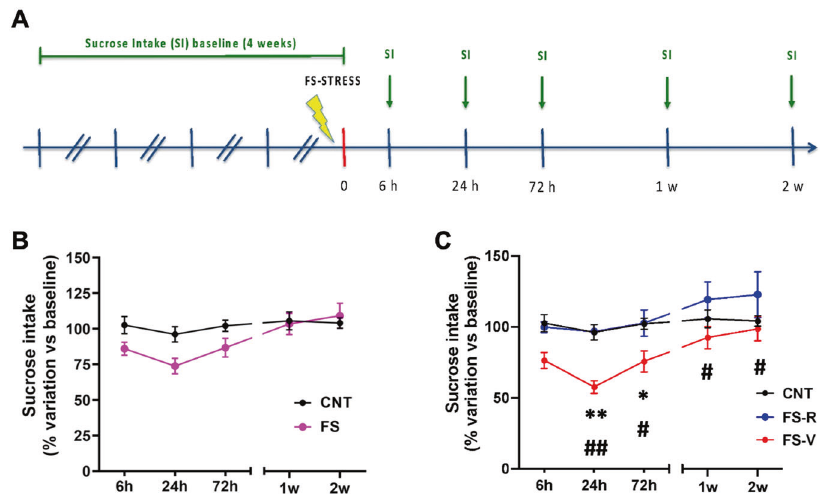
Fig. 2 Time course of sucrose intake in FS-R and FS-V animals. A Experimental plan timeline. Basal sucrose intake was established as before, animals were subjected to a single session of FS, and sucrose intake test was performed 6 h, 24 h, 72 h, 1 week, and 2 weeks after stress exposure. B Time-course of sucrose intake in CNT and FS rats. Mixed-effects model, Š ídák post-hoc test; N = 8 (CNT), 17 (FS). C Time-course of sucrose intake with separation in FS-R and FS-V. Mixed-effects model, Tukey ’ s post-hoc test: * p < 0.05, ** p < 0.01, # p < 0.05, ## p < 0.01; N = 8 (CNT), 7 (FS-R), 10